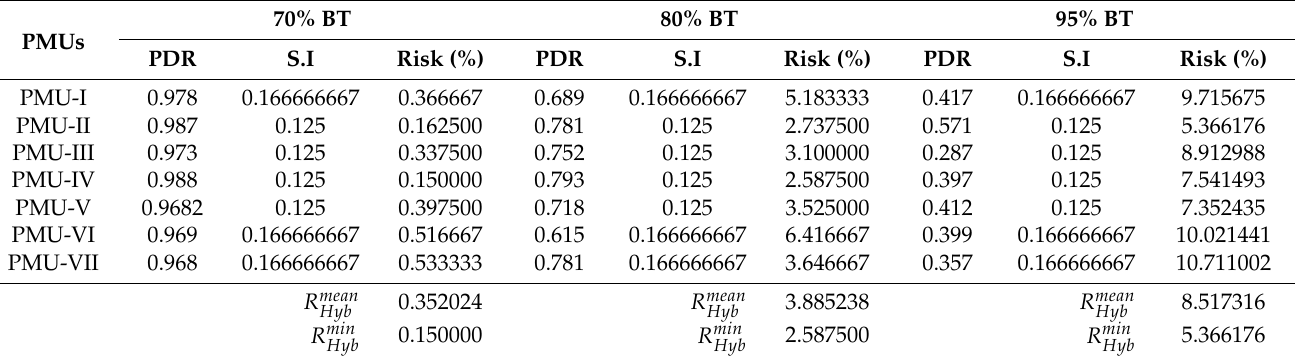
Table 7. Simulation results of hybrid SCN with 300 Kbps data rate under varying BT.